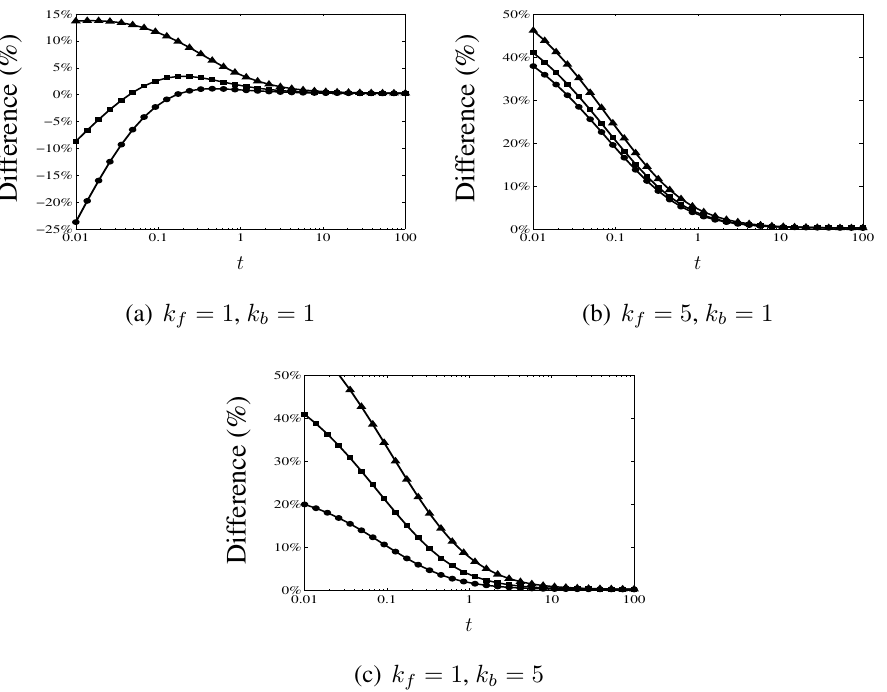
= 1 , D = 0 . 5 (triangles), D O R = 1 , D = 2 (circles). The analytical expression approaches O R